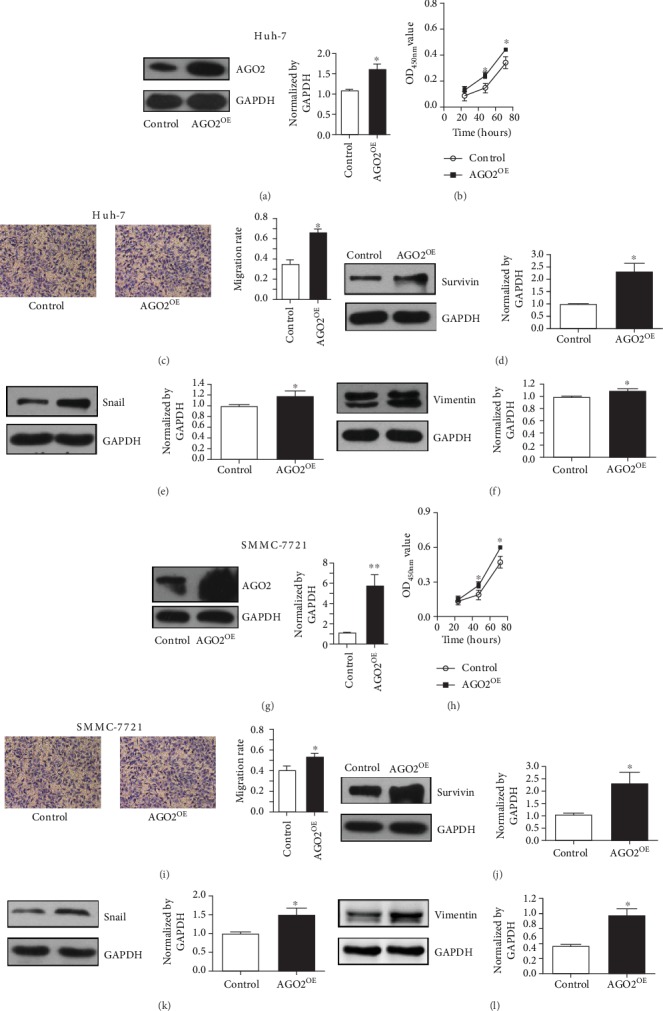
AGO2 overexpression promoted proliferation and migration of SMMC-7721 and Huh-7 in vitro. (a–f) Huh-7 cells were transiently transfected with pCMV3-AGO2 (AGO2OE) and an empty vector pCMV3 (control), respectively. (g–l) SMMC-7721 cells were used for AGO2 overexpression and subsequently analysis. Western blot was used to examine the effect of pCMV3-AGO2 transfection into Huh-7 (a) and SMMC-7721 (g) cells. (b and h) CCK8 assay was performed to detect cell proliferation of AGO2OE Huh-7 (b) and SMMC-7721 (h) cells. (c and i) Cell migration rates of AGO2OE Huh-7 (c) and SMMC-7721 (i) were determined by transwell assay. Western blot was performed to detect the effect of AGO2 overexpression on Survivin, Snail, and Vimentin expression in Huh-7 (d–f) and SMMC-7721 (j–l) cells. The ratio of Survivin, Snail, and Vimentin to GAPDH in Huh-7 and SMMC-7721 was measured by densitometric analysis of western blot bands, respectively. Values represented as the means ± S.D. (n > 3 each group); ∗P < 0.05, ∗∗P < 0.01, and ∗∗∗P < 0.005.